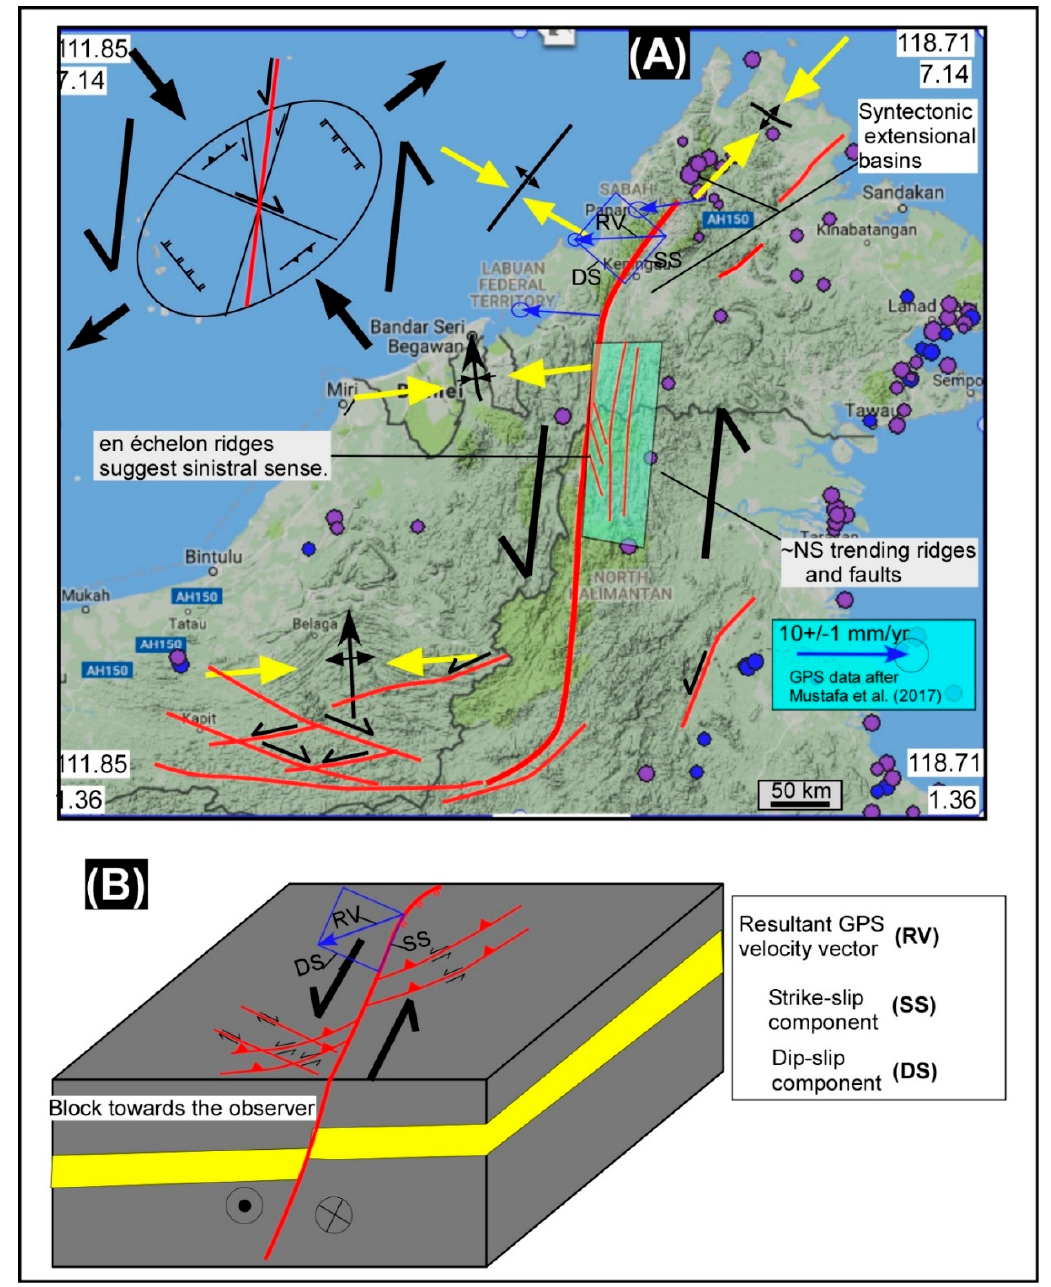
Figure 14. ( A ) Shows a tectonic model for the formation of structures that are mapped herein. A